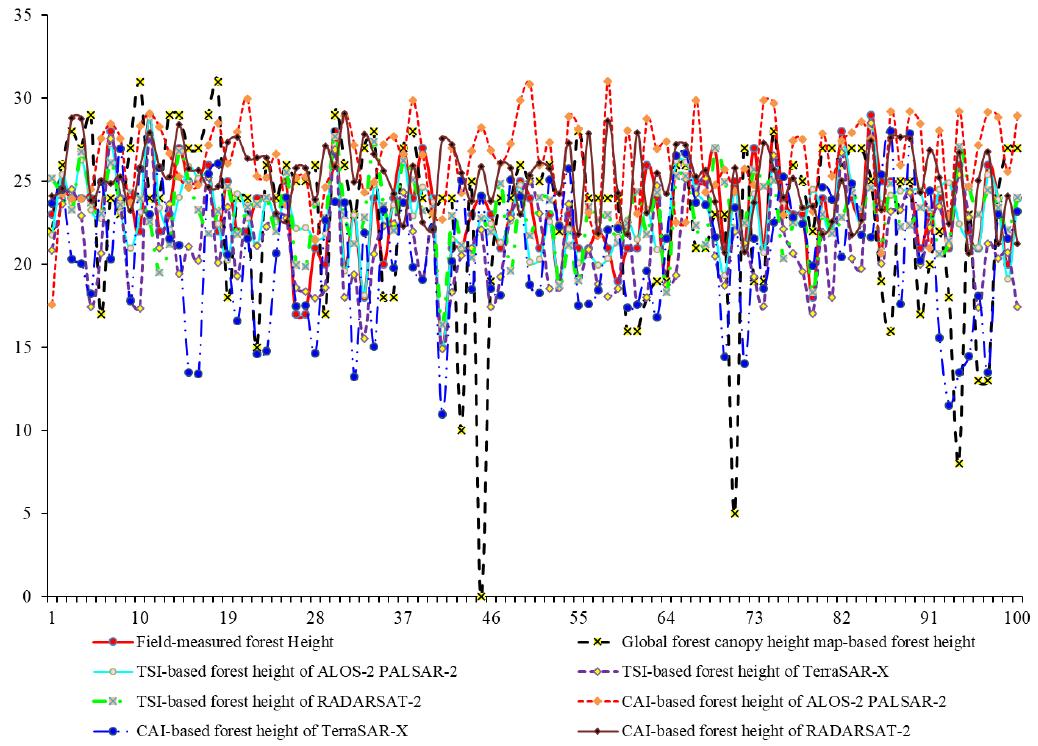
Figure 15. A comparison of forest height values of field-measured, PolInSAR-derived, and global canopy height map.